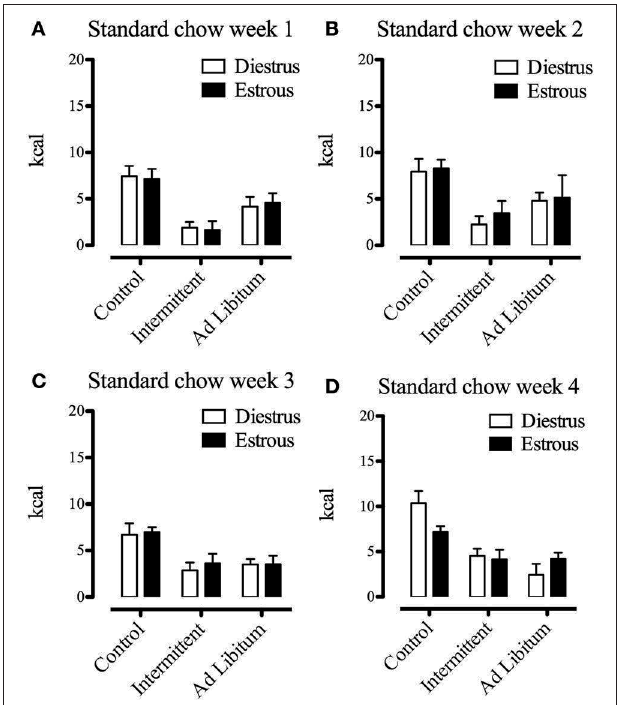
FIGURE 5 | Effects of estrous phase on energy intake (form sucrose) of animals differentially exposed to the sucrose solution after 1 (A) , 2 (B) , 3 (C) , and 4 (D) weeks from the beginning of the protocol ( n = 7–12). Sucrose solution intake was measured in grams during a 2-h period, converted to kcal and expressed as means ±